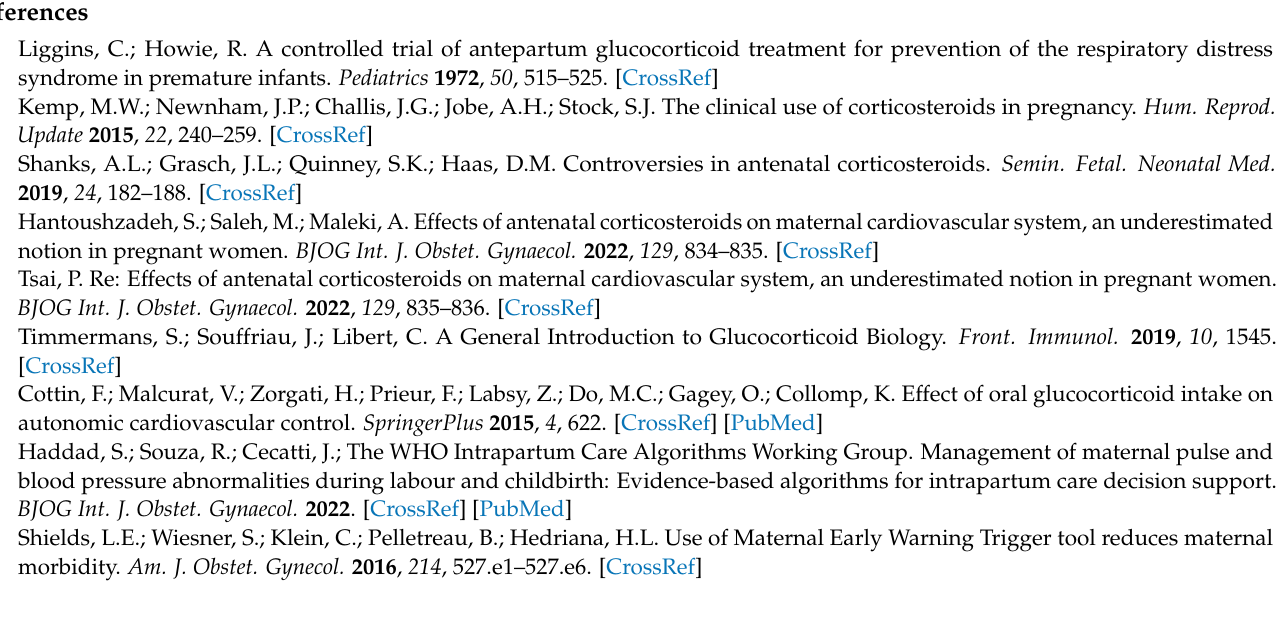
Figure A4. Boxplots of maternal HRV on days 0 to 5 , excluding all participants who were also administered anti-hypertensive medications. Boxplots represent the median, interquartile range, and interdecile range of the values. Day 0 represents measurements taken before the first injection of betamethasone, while day 1 represents 24 h after the first injection, day 2 represents 48 h after the first injection, etc. * represents a statistically significant finding with p < 0.05, while ** presents p < 0.01 and *** represents p < 0.001. The number of measurements incorporated into each day is displayed at the top of the graph.